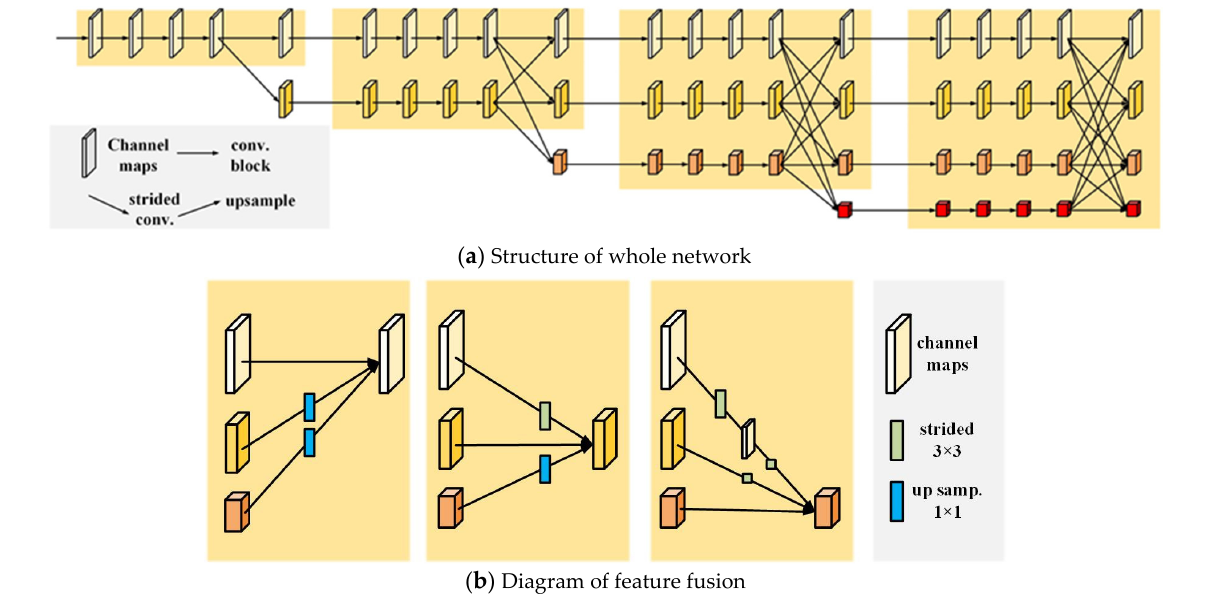
Figure 3. HRNet network structure. Table 2. The situation of land types corresponding to the cultivated land patches in the second and third national land surveys.